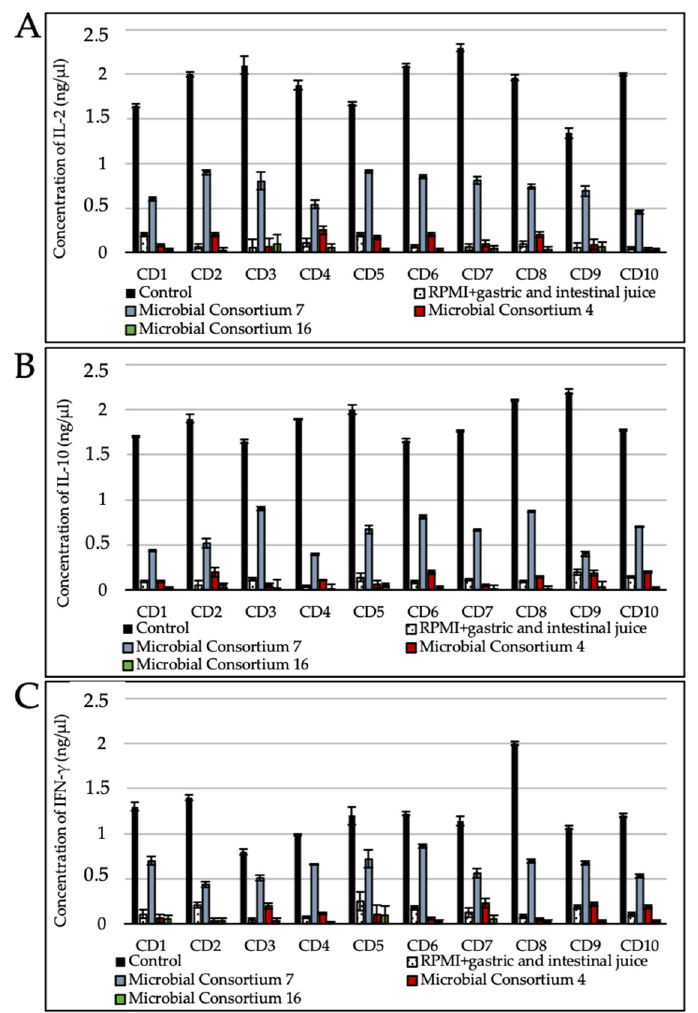
Figure 4. Concentration (ng/ µ L) of interleukin 2 (IL-2) ( A ), interleukin 10 (IL-10) ( B ), and interferon gamma (IFN- γ ) ( C ) in duodenal biopsy specimens from patients with CD. Analyses were carried out in two independent experiments. Control, wheat bread digested without the addition of bacterial cells and microbial enzymes; RPMI+gastric and intestinal juice, negative control; Consortium 4, wheat bread digested with the addition of live and lysed cells of Lp. plantarum DSM33363 and DSM33364, Lc. paracasei DSM33373, B. subtilis DSM33298, and B. pumilus DSM33301 and E1, E2, Veron PS, and Veron HPP commercial enzymes); Consortium 7, wheat bread digested with the addition of live and lysed cells of Lp. plantarum DSM33362, DSM33366, and DSM33370, Ls. reuteri DSM33374 , B. megaterium DSM33356, and B. subtilis DSM33353 and E1, E2, Veron PS, and Veron HPP commercial enzymes; and Consortium 16, wheat bread digested with the addition of live and lysed cells of Lp. plantarum DSM33363 and DSM33364, Lc. paracasei DSM33373, Ls. reuteri DSM33374, B. megaterium DSM33300, B. pumilus DSM33297 and DSM33355 and E1, E2, Veron PS, and Veron HPP commercial enzymes. CD1 to CD10, duodenal biopsy specimens from celiac pa- tients. The evaluation was conducted on biological duplicates and the mean values (± standard deviation) were reported. 4. Discussion Using a large number of strains (504) previously isolated from the human intestine or food matrices and environmental samples, this study preliminarily selected 131 strains belonging to species of Bacillus (64), lactobacilli (63), Pediococcus (1), and Weissella (3) which showed marked resistance to in vitro gastrointestinal conditions. All of the se-